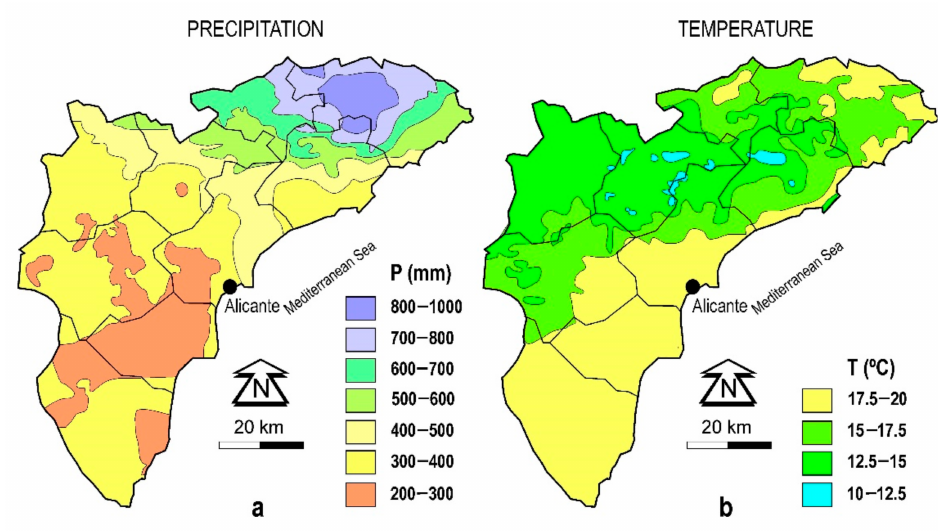
Figure 2. Spatial distribution of ( a ) mean annual p (P) in mm and ( b ) temperatures (T) in ◦ C in the province of Alicante from 1971 to 2000. Modified from the Climatic Atlas viewer [56]: http: //agroclimap.aemet.es (accessed on 15 October